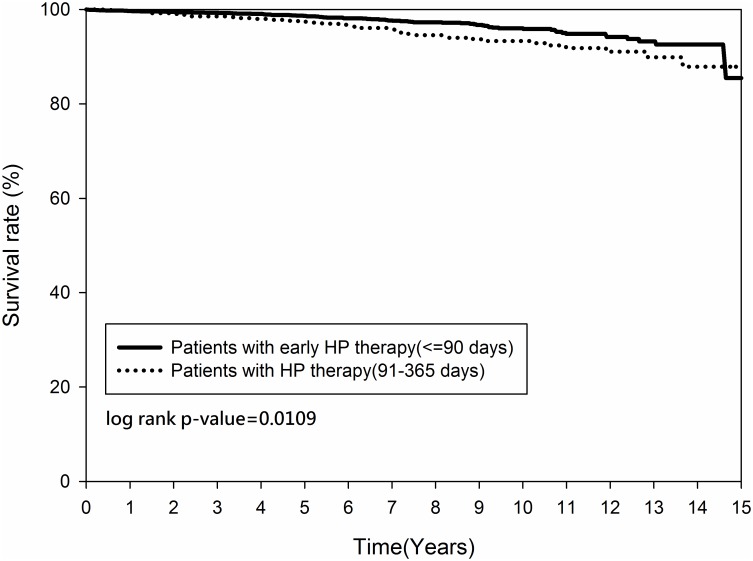
Kaplan-Meier curve for mortality rate between patients with early and non-early Helicobacter pylori therapy.